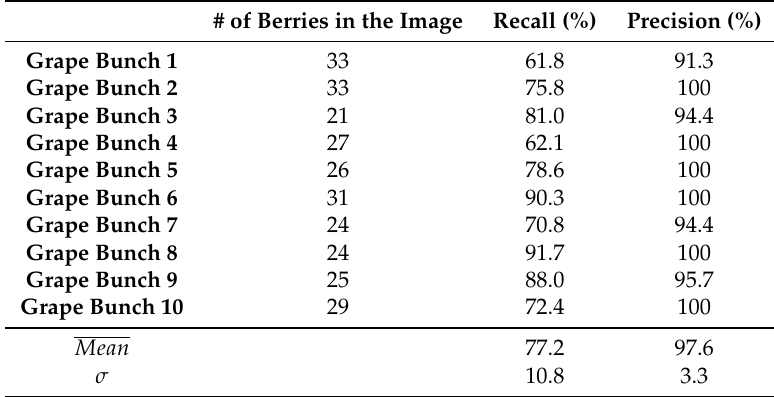
Table 7. Berry recall and precision for berry yield parameter estimation on 10 grape bunches of the SMPH grapevine row.